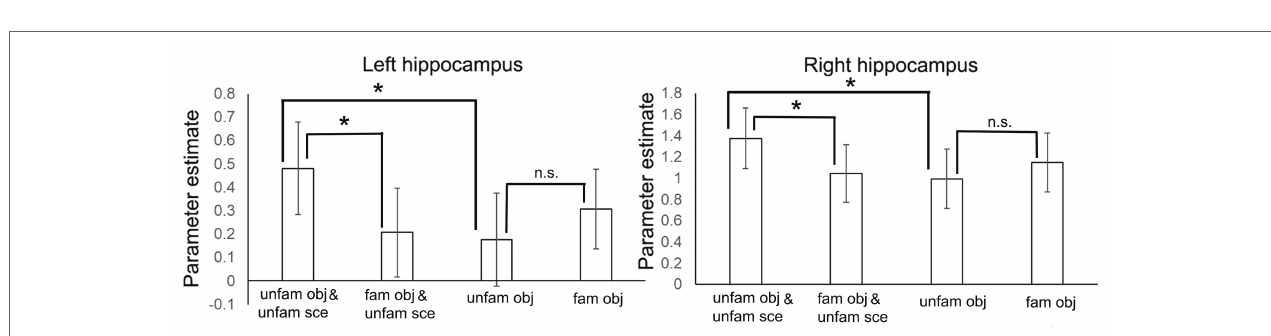
FIGURE 3 | Results for the medial-temporal volume of interest analysis. (A) Coronal, (B) Axial, and (C) Sagittal (left) MRI brain slices depicting a bilateral posterior hippocampal regions that showed a significant interaction effect for the factors of Familiarization (non-familiarized vs. familiarized) and Arrangement (single object vs.